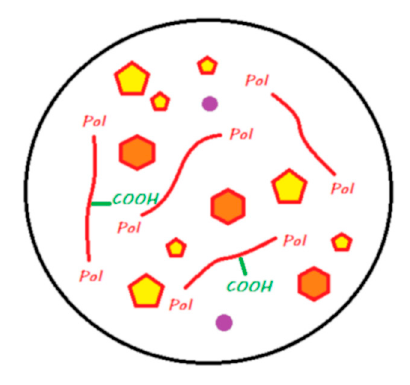
Figure 11. A compomer in its storage medium. This material contains, schematically, silane-treated reactive FAS fillers and unreactive fillers, a blend of monomers including dehydrated acidic monomers and camphorquinone, but does not contain any water.